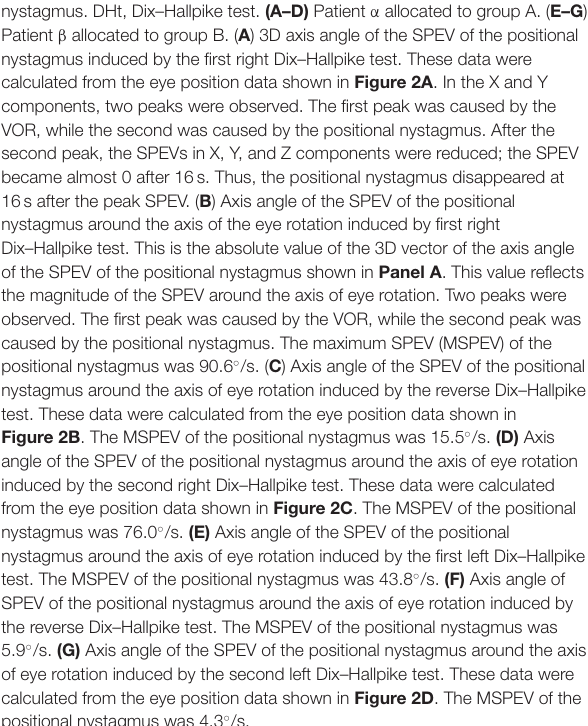
Two peaks were seen. The first peak resulted from VOR, while the second peak resulted from positional nystagmus, and the peak SPEV of the positional nystagmus (90.6 ◦ /s) was